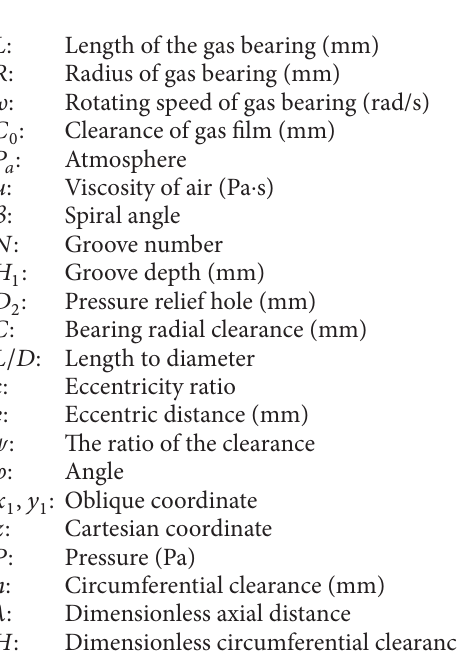
Figure 21: Schematic diagram of the grids distribution under oblique coordinate